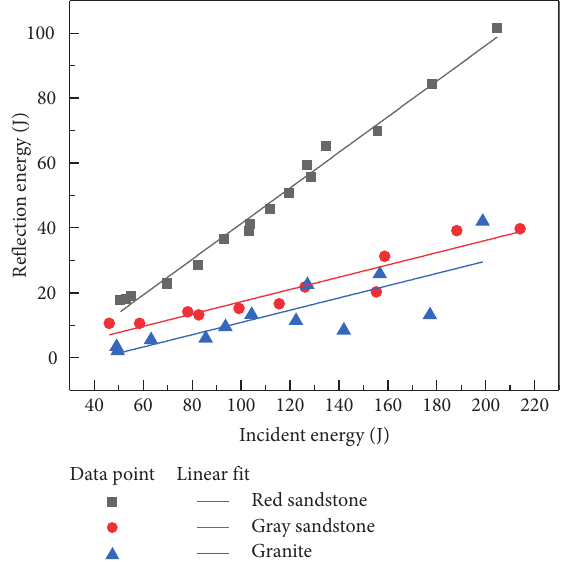
Figure 11: Reflection energy-incident energy diagram.